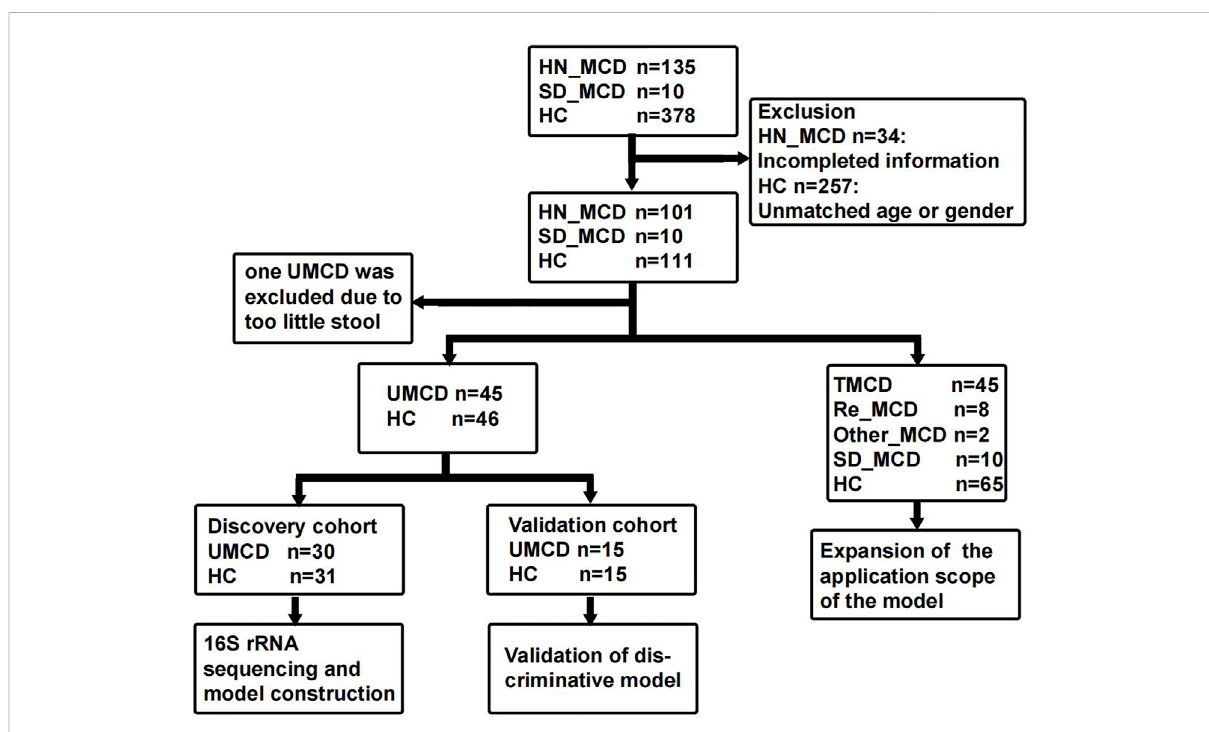
FIGURE 1 Study design and fl ow diagram. The fecal samples including MCD patients and healthy controls from two medicine centers of China were collected.Afterexclusion,atotalof222fecalsampleswereenrolledinthestudy.In111fecalsamplesfrompatientswithMCD,101werefromtheFirst Af fi liated hospital of Zhengzhou University in Henan province and 10 were from Shandong Provincial Hospital. In 101 HN_MCD patients, 46 of them were fi rst onset MCD without treatment and were de fi ned as UMCD, while the rest was composed of 45 treated MCD, eight relapse MCD and two other types of MCD. Ten MCD patients from Jinan were also without a history of application of drugs. Except one sample with too little stool, 45 UMCDs and matched HCs were randomly divided into discovery cohort and validation cohort. We compared the gut microbial alteration in discovery cohort and selected key OTUs as biomarker to construct diagnostic model. Then we tested the ef fi ciency in validation cohort. We also validated the diagnostic ef fi ciency in SD_MCD, Re_MCD and TMCD cohorts to explore the applicable population and scope. MCD, minimal